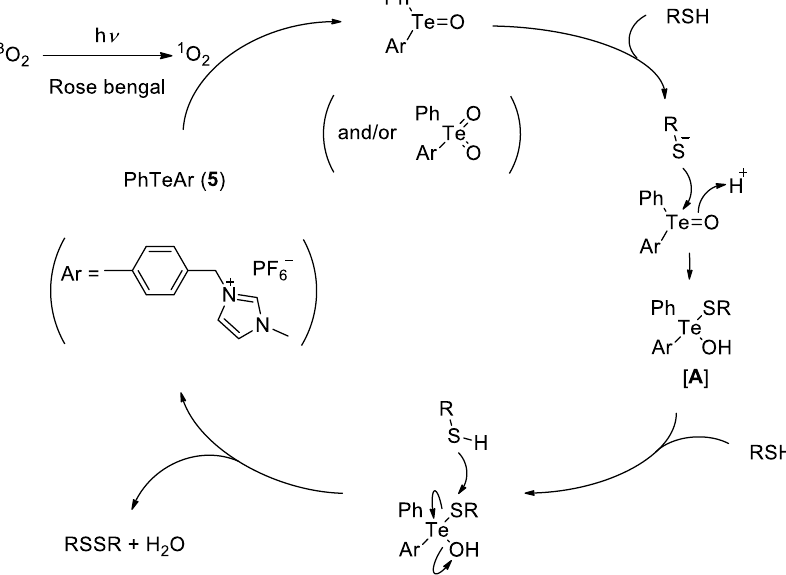
Figure 1. Plausible reaction mechanism for the catalytic oxidation of thiols.